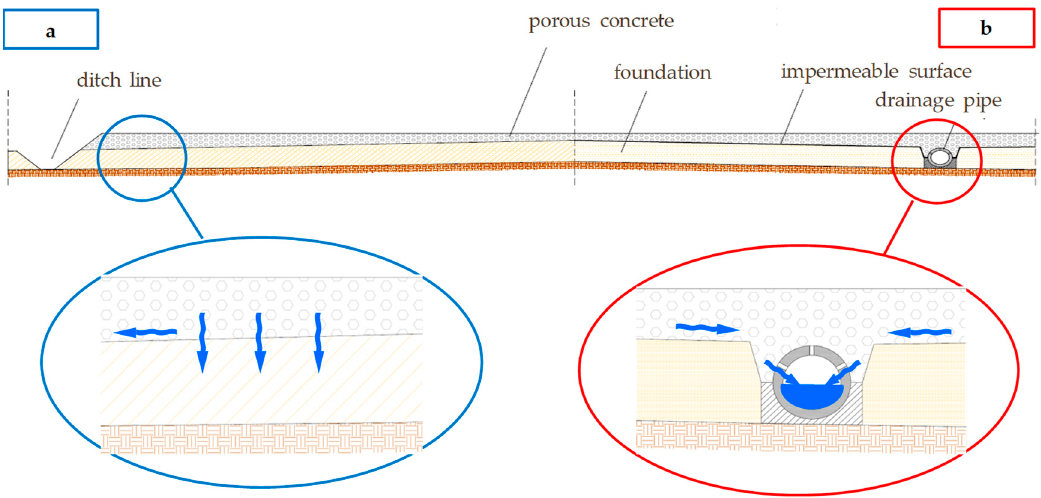
Figure 2. Operating systems of pervious pavements: ( a ) returning water to aquifers and ( b ) collecting water in retention basins.